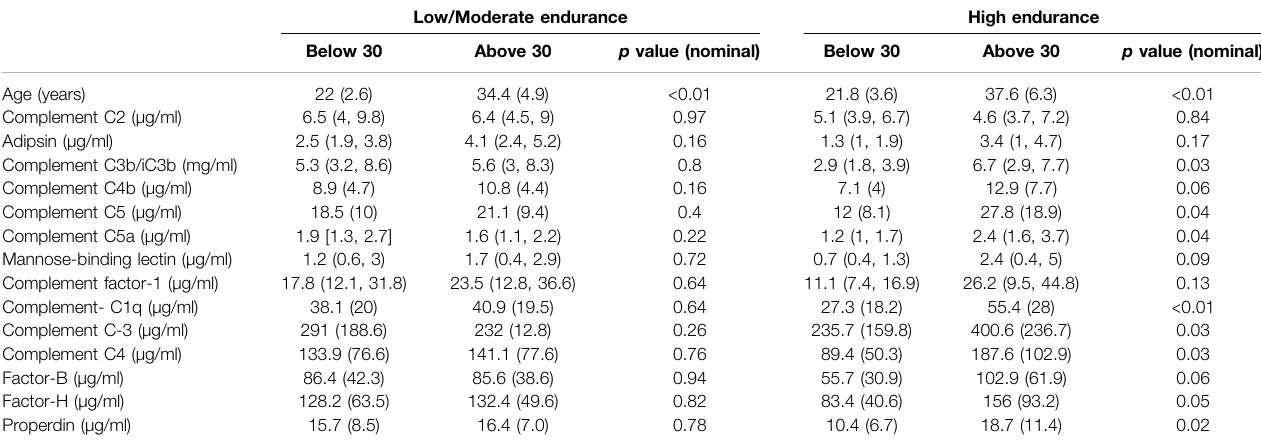
TABLE 3 | Comparing complements between different age groups in low/moderate and high endurance elite athletes. Low/Moderate endurance High endurance Below 30 Above 30 p value (nominal) Below 30 Above 30 p value